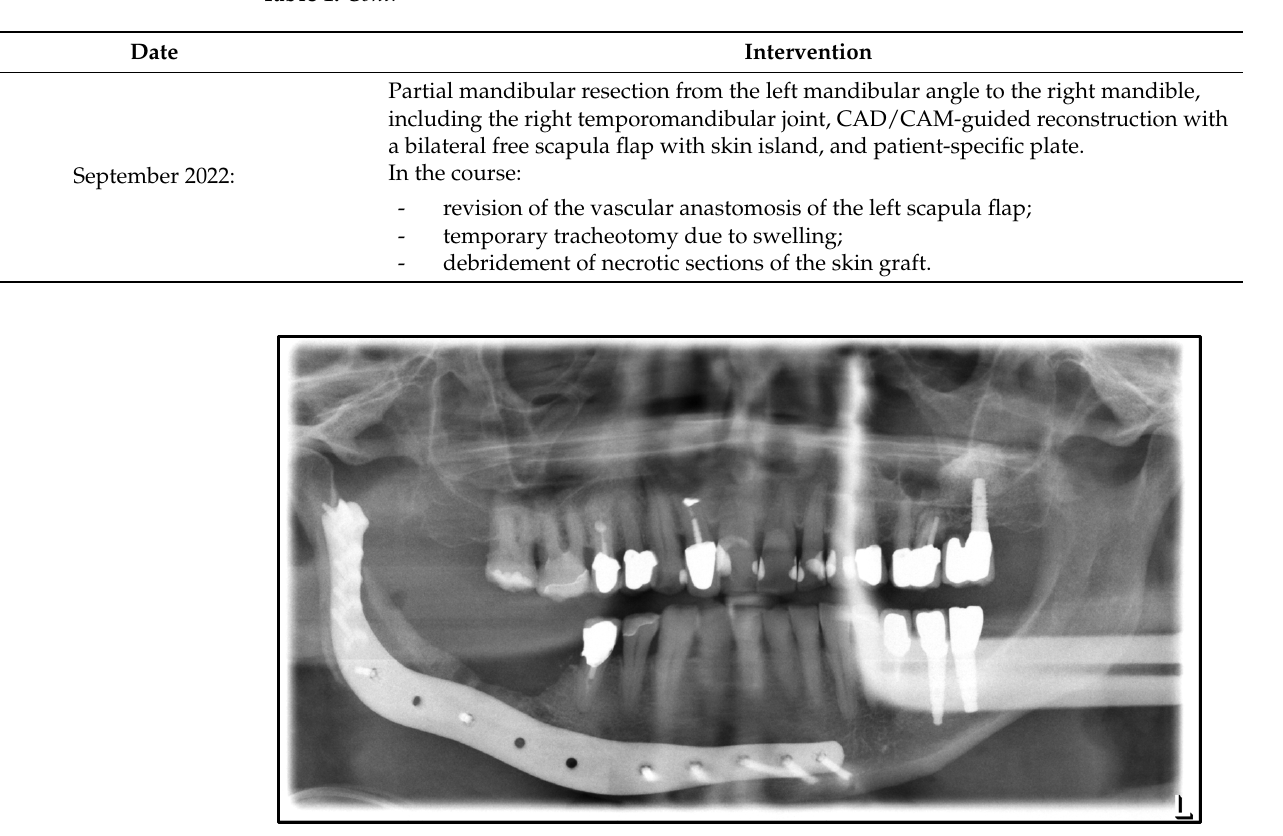
Figure 1. Dental X-ray after mandibular box resection and protective osteosynthesis, July 2014. In 2017, a reosteosynthesis was performed using a conventional hand-bent reconstruc- tion plate due to chronic fistulation. A continuity resection was done one year later because of recurrent submental fistulation. The plate was replaced again by a patient-specific plate (Figure 2).